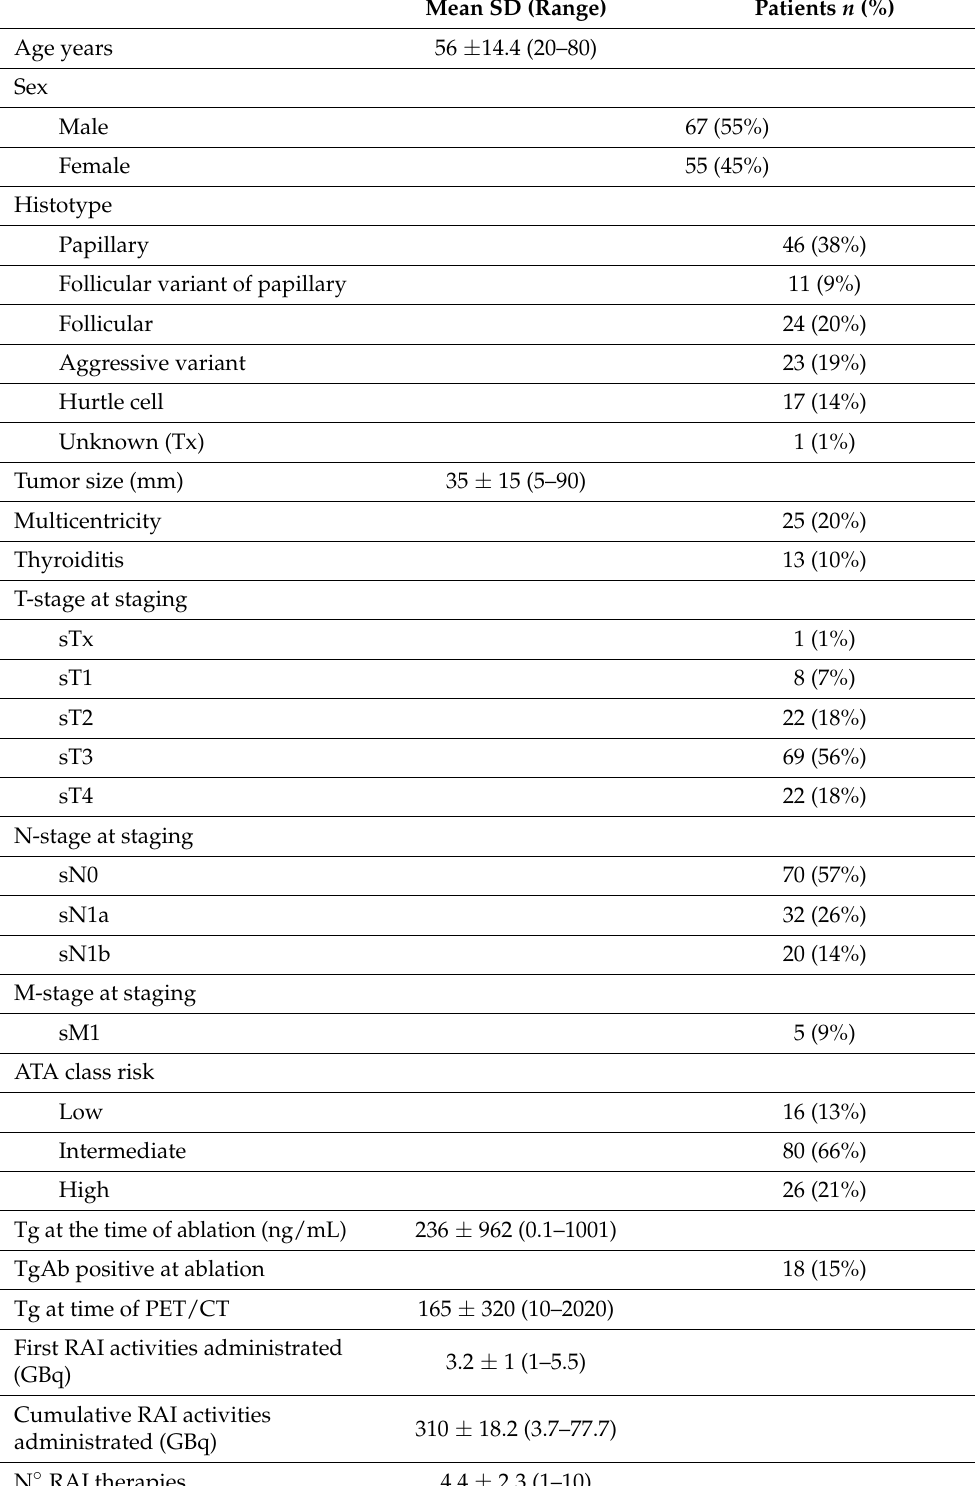
Table 1. The main characteristics of our patients ( n =